Question: In a single sentence, describe what this figure presents.
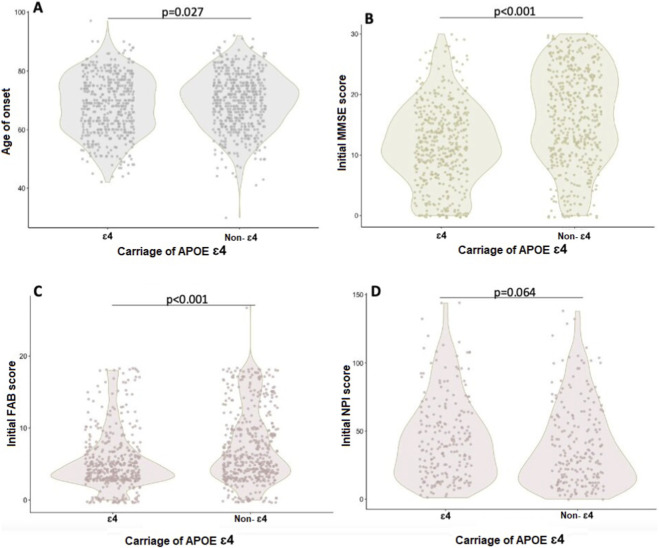
Answer: Violin plots illustrating differences in clinical characteristics according to APOE ε4 carrier status (A) comparison of age at disease onset between APOE ε4 carriers and non-carriers; (B) comparison of initial Mini-Mental State Examination (MMSE) scores according to APOE ε4 carriage; (C) differences in initial Frontal Assessment Battery (FAB) scores between APOE ε4 carriers and non-carriers; (D) comparison of initial Neuropsychiatric Inventory (NPI) scores based on APOE ε4 carrier status.